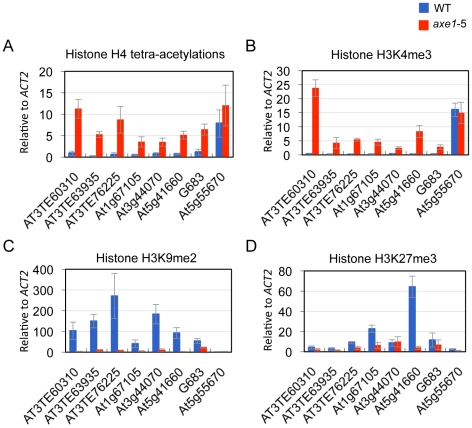

HDA6 mutation causes abolishment of heterochromatic
mark and elevation of euchromatic modifications.ChIP-qPCR assays were performed for quantitative analysis of histone
modifications, using antibodies against; (A) H4 tetra-acetylation, (B)
H3K4me3, an active euchromatic mark, (C) H3K9me2, and (D) H3K27me3, a
constitutive heterochromatic or repressive mark. Equal amounts of input
DNA and the immunoprecipitates were analyzed and normalized against
input DNA. The values obtained were normalized again using
ACT2 and are shown as the means and standard
deviations from three independent immunoprecipitated DNA analyses (blue,
WT; red, axe1-5). At5g55670 with no
apparent transcriptional difference between axe1-5 and
WT was used as a negative control.